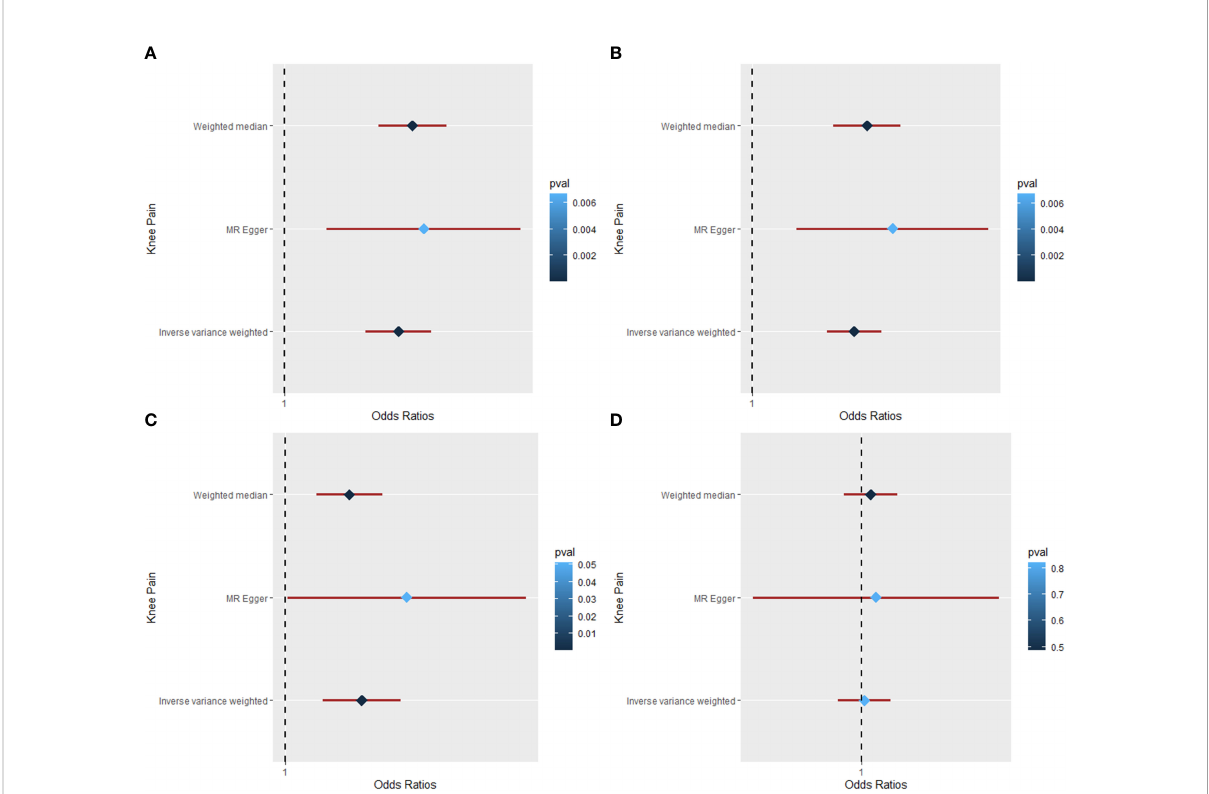
FIGURE 2 The Mendelian randomization analysis for causal effects of obesity on knee pain. (A) Forest plot about the causal effect of body mass index on knee pain. (B) Forest plot about the causal effect of waist circumference on knee pain. (C) Forest plot about the causal effect of hip circumference on knee pain. (D) Forest plot about the causal effect of waist-to-hip ratio on knee